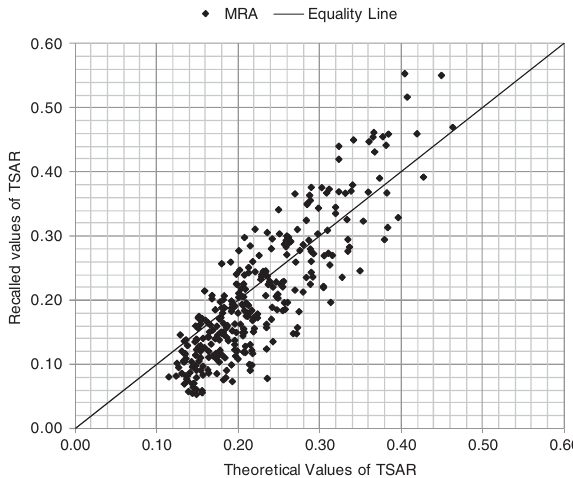
Fig. 15. Predicted D TM values by multiple nonlinear regression vs. theoretical data (Set 2)